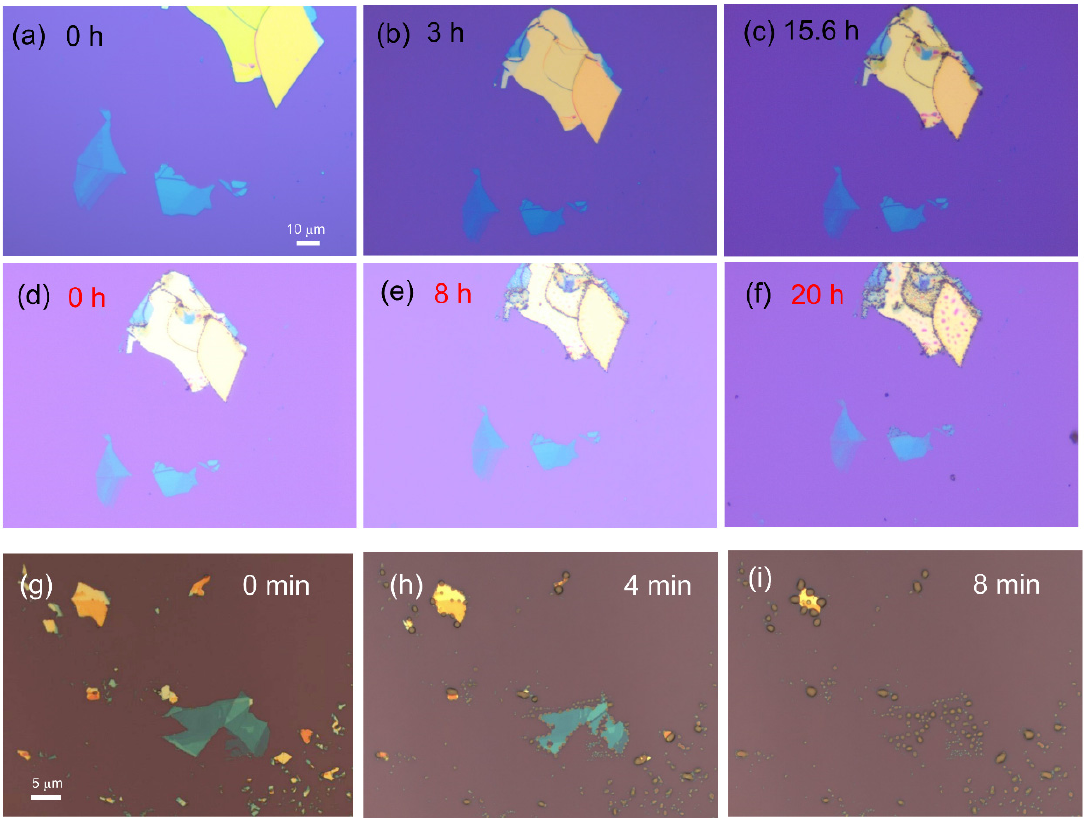
Figure 3. Optical microscopy images of ( a – c ) CrBr 3 flakes placed in ambient atmosphere for 0 h, 3 h, and 15.6 h, respectively. ( d – f ) The CrBr 3 flakes exposed to light irradiation for 0 h, 8 h, and 20 h after storage in ambient atmosphere for 3 days. ( g – i ) The CrBr 3 flakes exposed to stronger light irradiation in ambient atmosphere for 0 min, 4 min, and 8 min, respectively.